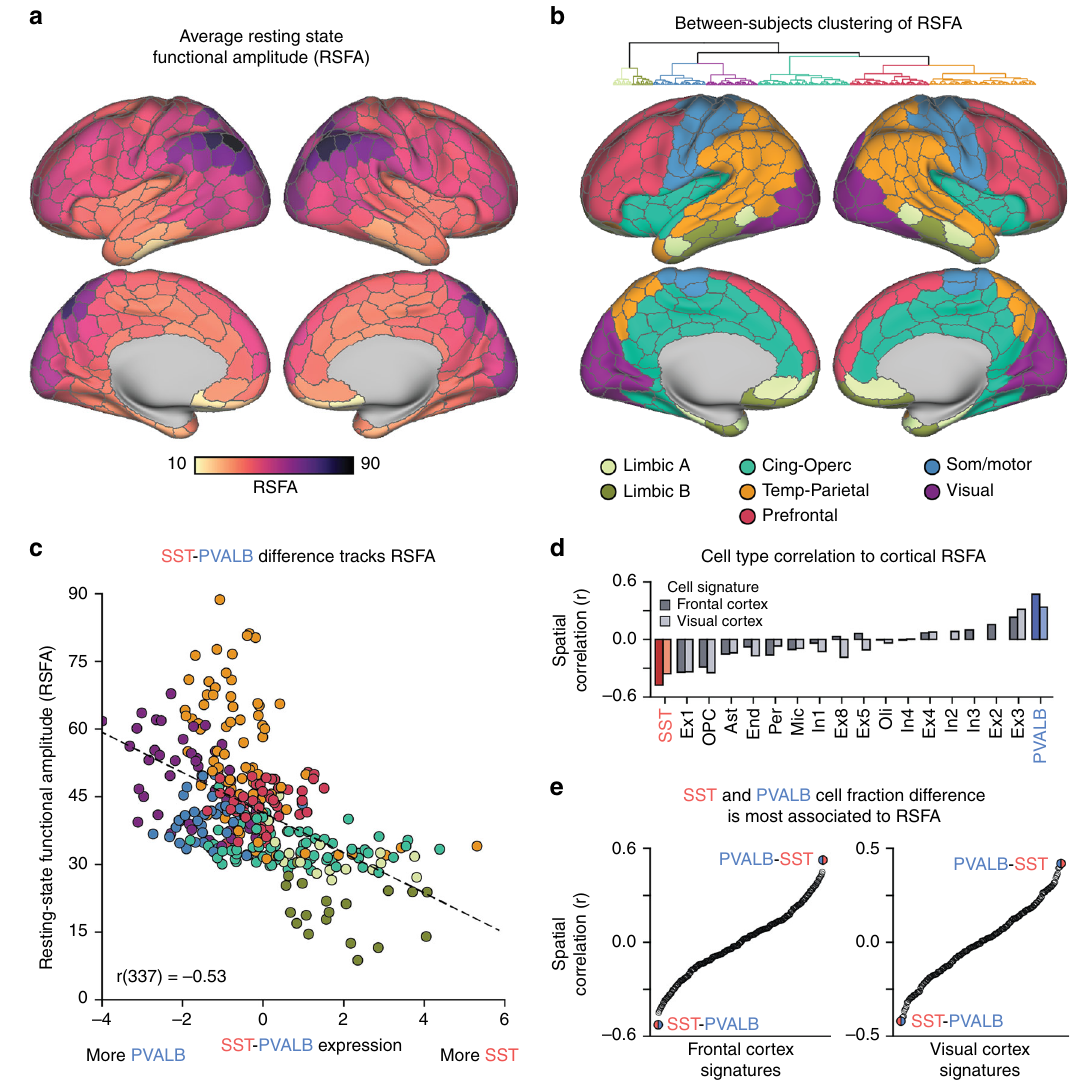
Fig. 4 SST – PVALB difference tracks inter-regional variation in cortical brain function. a RSFA across each of the 400 Schaefer atlas parcels, averaged across 9713 UKB subjects. b Between-subject hierarchical clustering of residualized RSFA reveals 7-clusters cortical partitions with similar amplitude signatures; Light beige = limbic A, dark beige = limbic B, teal = cingulo-opercular, orange = temporal-parietal, red = prefrontal, blue = somato/motor, and purple = visual. c Relative presence of SST – PVALB is negatively correlated (Pearson ’ s) with cortical RSFA ( r (337) = − 0.53, p < 2.2e − 16). d Across all deconvolved cell types, RSFA is most negatively spatially correlated (Pearson ’ s) to SST cell fractions (frontal cortex signature: r (337) = − 0.48, p < 2.2e − 16; visual cortex signature: r (337) = − 0.36, p = 1.2e − 11) and most positively correlated to PVALB cell fraction (frontal cortex signature: r (337) = 0.47, p < 2.2e − 16; visual cortex signature: r (337) = 0.34, p = 1.7e − 10). e Across frontal cortex ( n = 272) and visual cortex ( n = 240) cell type pairs, the relative difference of SST and PVALB cell fractions is most spatially associated with cortical